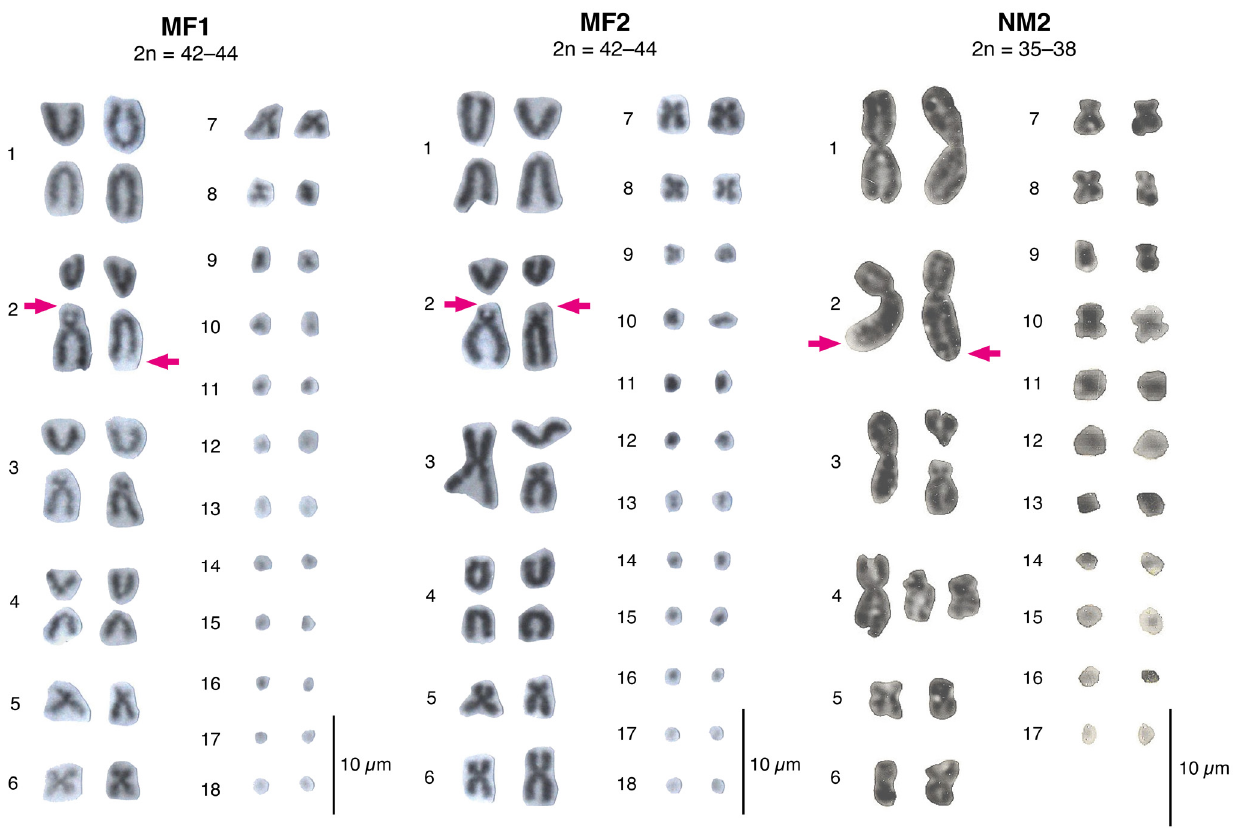
Figure 2. Representative karyotypes for the newly described races of L. monticola . Arrow indicates the NOR position on chromosome pair 2. Individuals whose chromosomes are shown are: L2180 (MF1 race), L1362 (MF2 race), and L730 (NM2